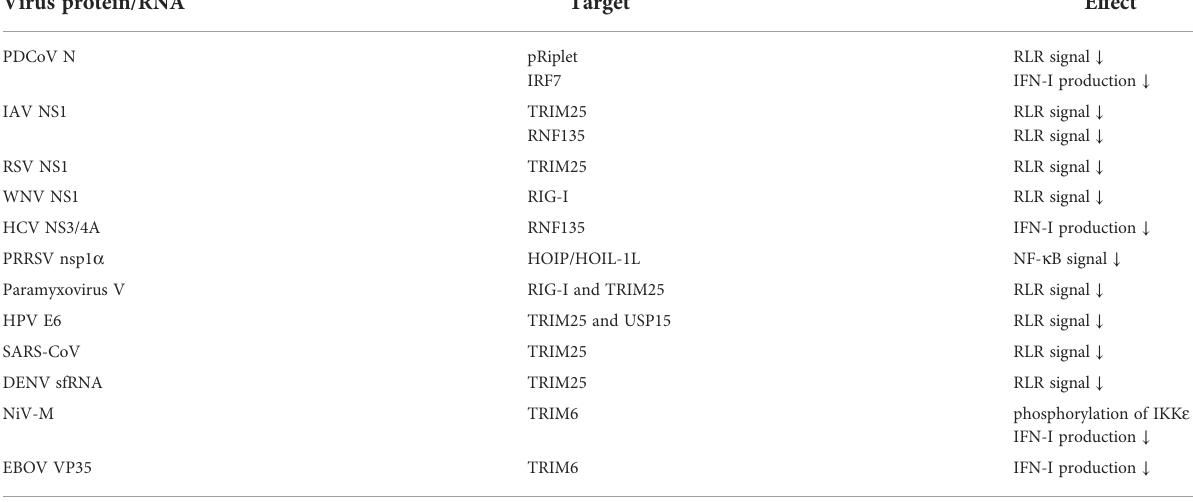
TABLE 2 Binds and blocks E3-substrate pairs. Virus